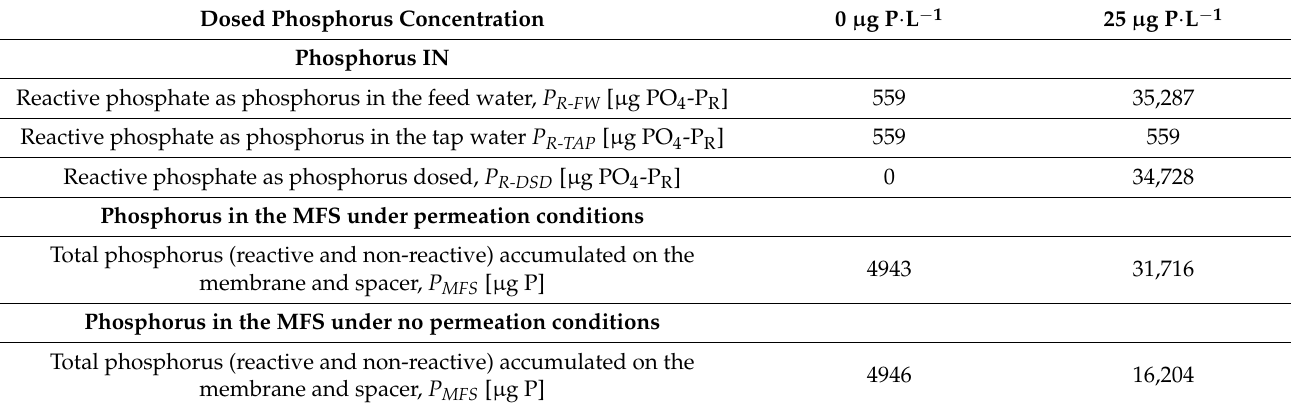
Table 2. Phosphorus amount after 4.7 days of MFS